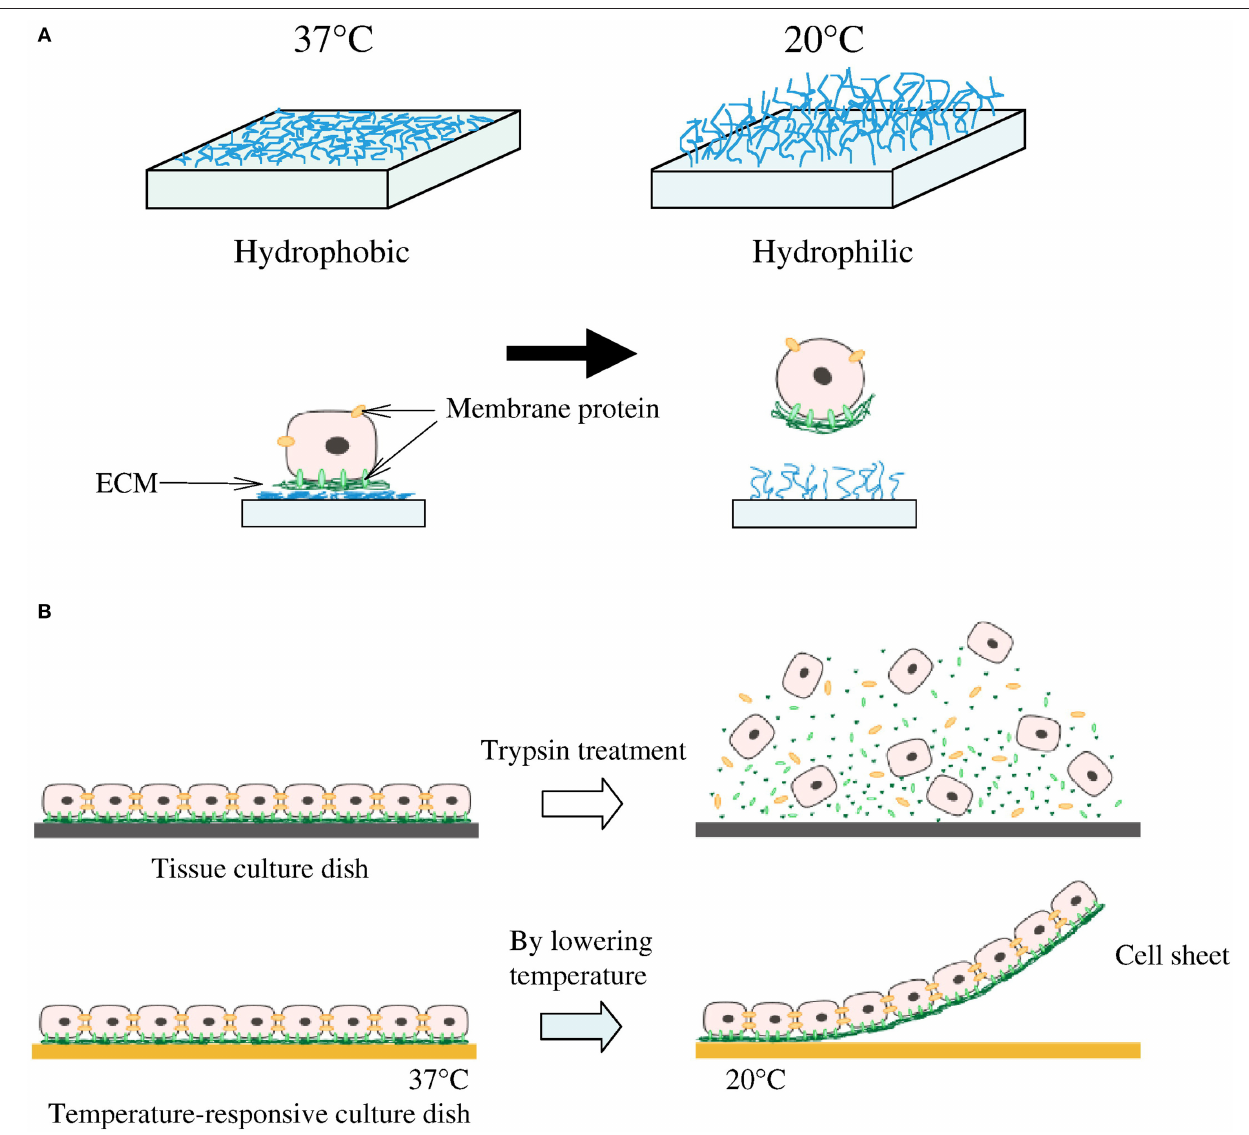
FIGURE 2 | Cell sheeting. (A) At 37 ◦ C cells attach to the hydrophobic surface and at lower than 32 ◦ C detach from the hydrophilic surface. (B) Cells connect to each other by cell-to-cell junctions and ECM; when enzymes are introduced to remove cells from the surface, these junctions and ECM are disrupted. This is not the case for the temperature-responsive culture surface which is able to preserve the cell-to-cell junction and ECM. Reprinted from Moschouris et al. (87,